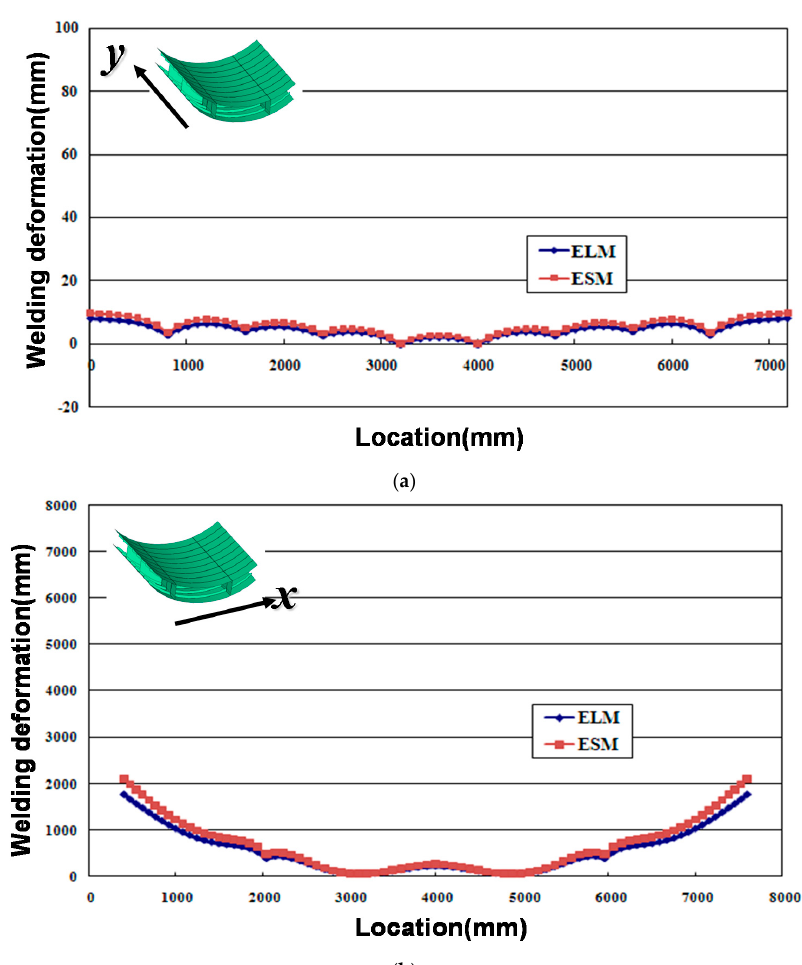
Figure 14. Welding deformation of a curved double bottom block: ( a ) y -direction, ( b ) x -direction.